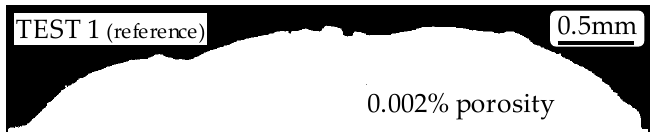
Figure 3. Test No. 1—reference test results.